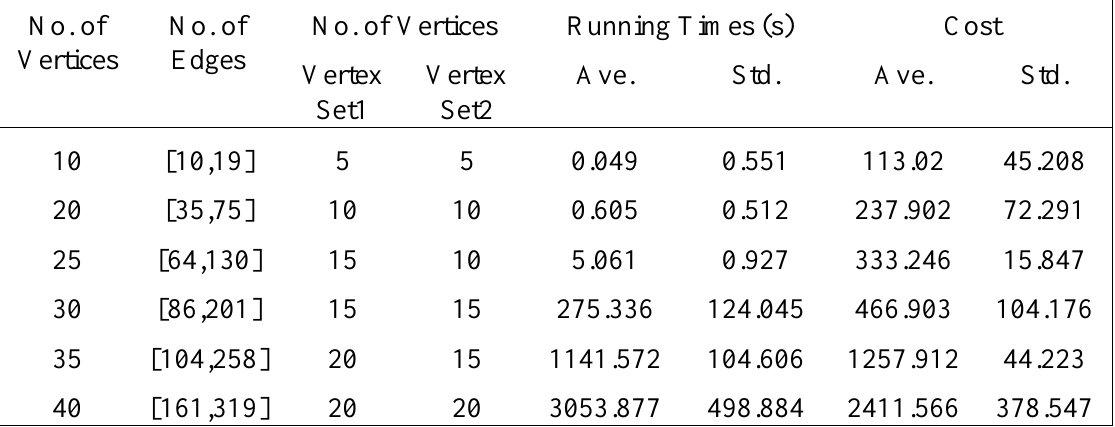
Table 1: Results on artificial graphs with different numbers of vertices, including the averages and standard deviations of cost and running times. Costs and running times are averaged over 5 repeats on 5 inputs.